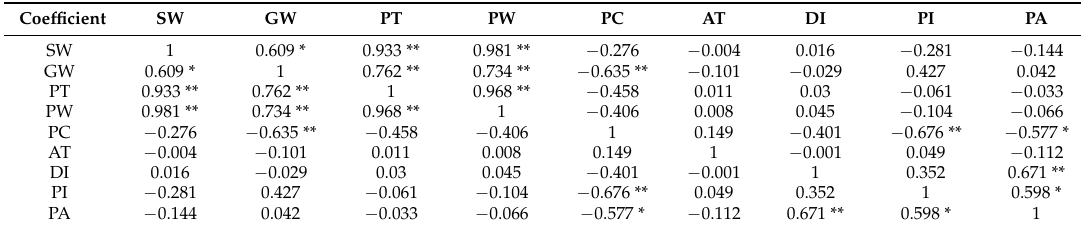
Table 3. Output results of correlation coefficient.